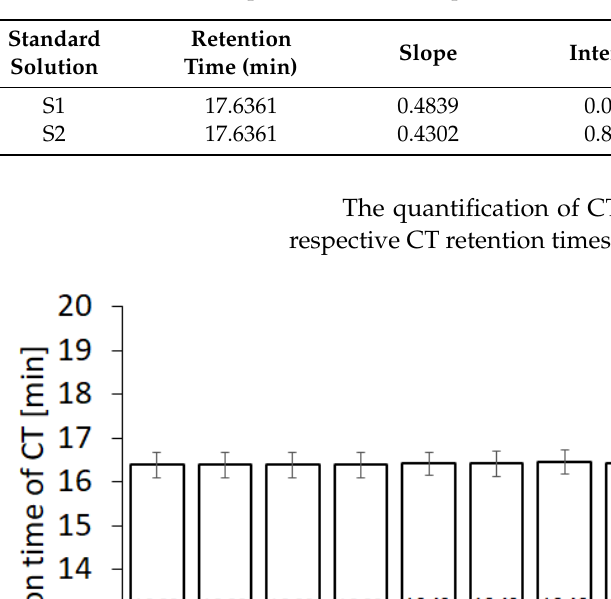
Table 3. Equations of standard plots for the evaluation of CT concentration in the HPLC assays.